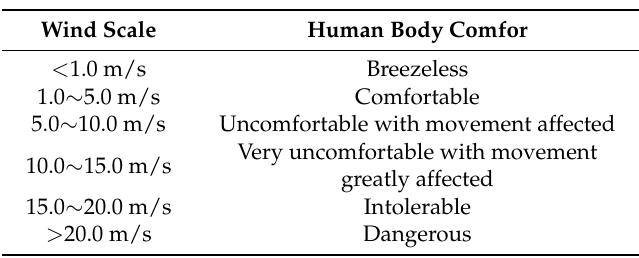
Table 3. Wind scales and human body comfort [34].